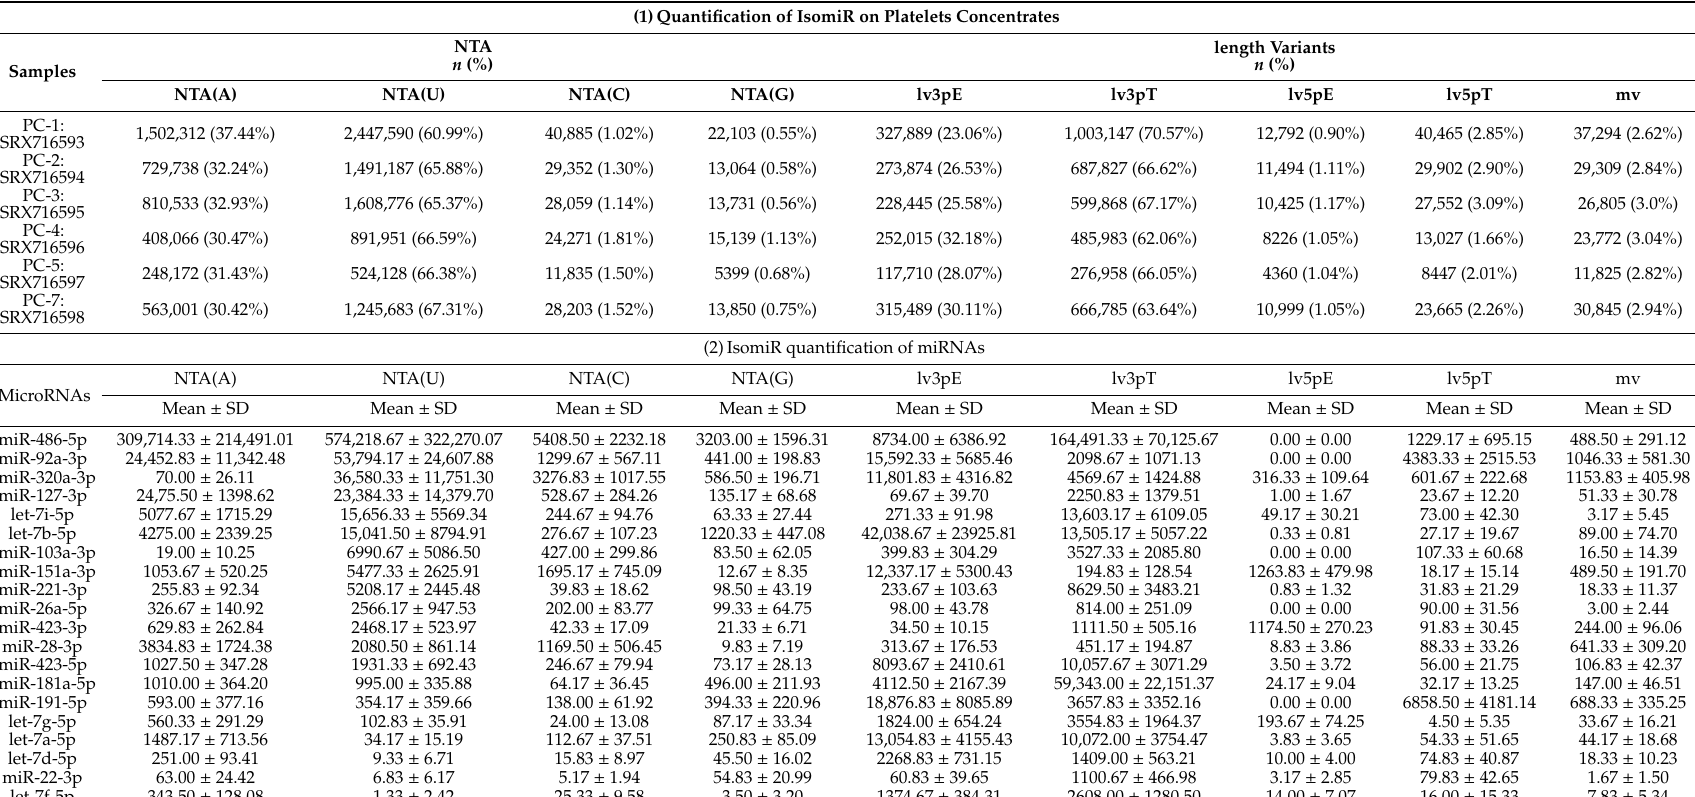
Table 3. Quantification and detection of isomiR variants on platelets